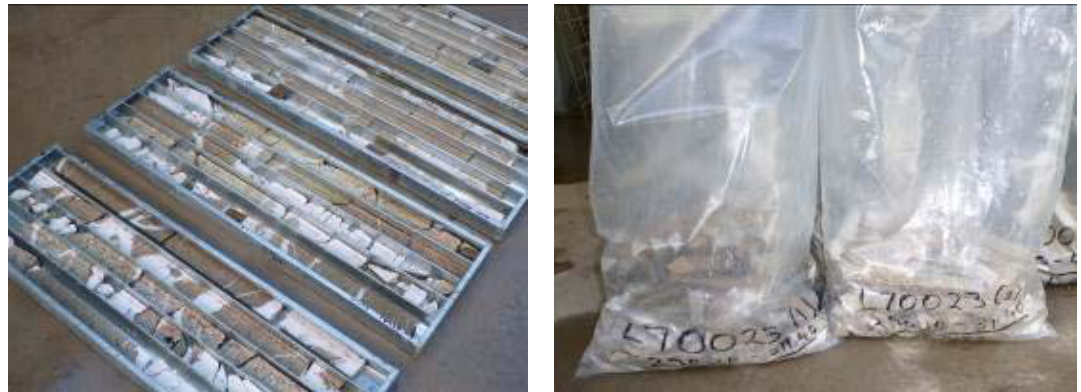
Figure 4. ( Left ): Half NQ2 core prior to quarter cutting for testwork. NQ2 is a standard wireline diamond drill type, where the core diameter is 50.6 mm to yield approximately 5.5 kg/m for whole core; ( Right ): Quarter cut core bagged prior to transportation to the laboratory. This intersection was combined with another to form a 50 kg composite sample for GRG testwork.